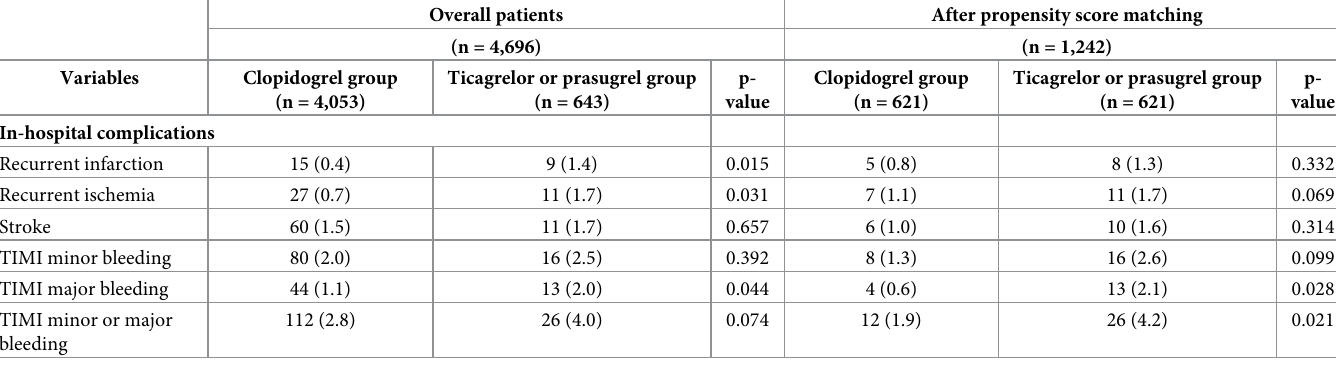
Table 3. Complications during hospitalization of the clopidogrel and ticagrelor or prasugrel groups. Overall patients